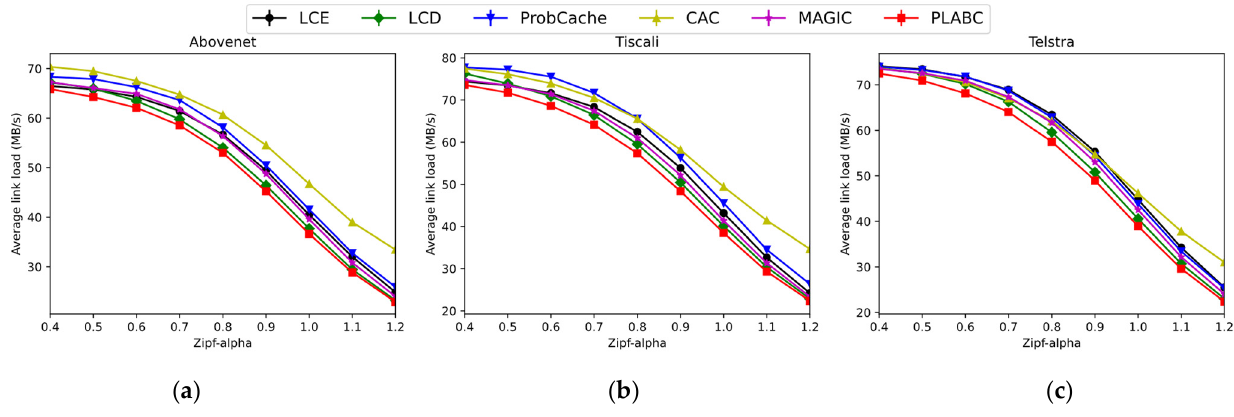
Figure 13. Average link load results of different caching strategies when Zipf exponent alpha varies under topology: ( a ) Abovenet; ( b ) Tiscali; ( c ) Telstra.